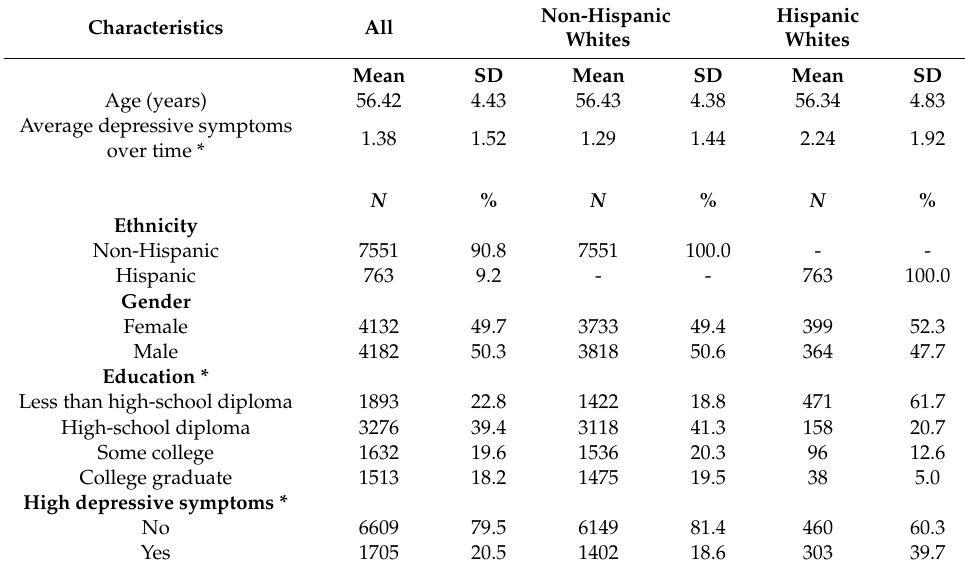
Table 1. Descriptive statistics ( n =